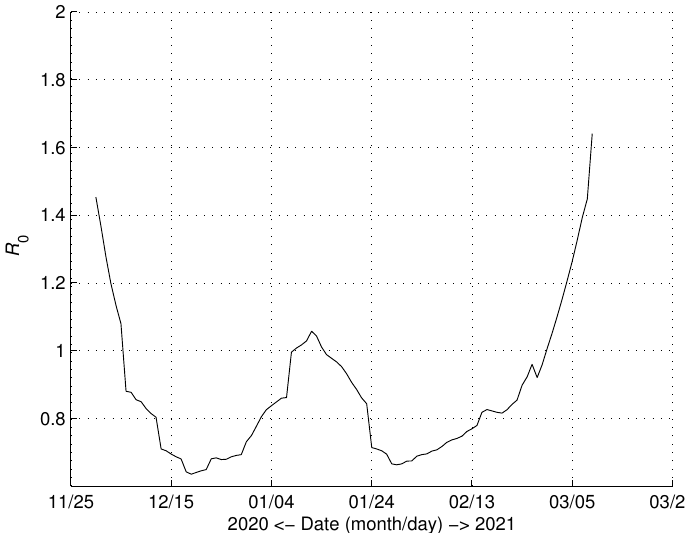
Figure 2. R 0 for Germany from 30 November 2020 to 9 March 2021.